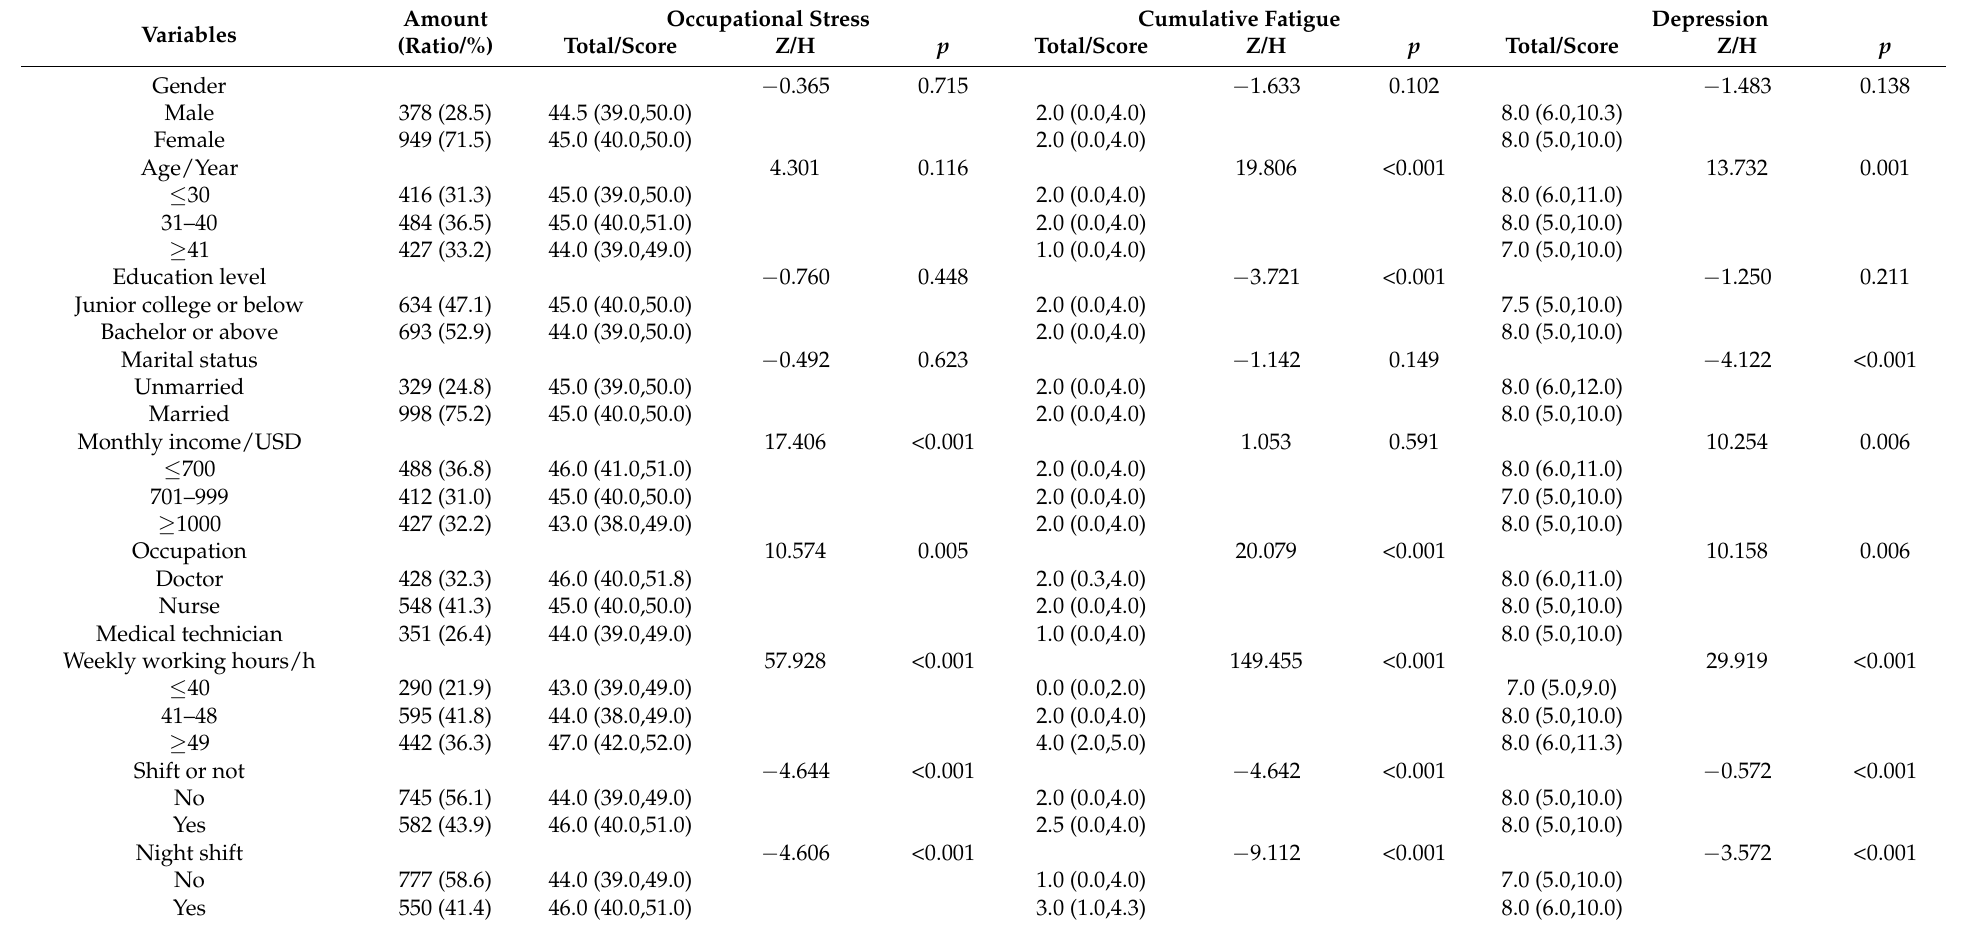
Table 4. Characteristics and scores of occupational stress, depressive symptoms, and cumulative fatigue among